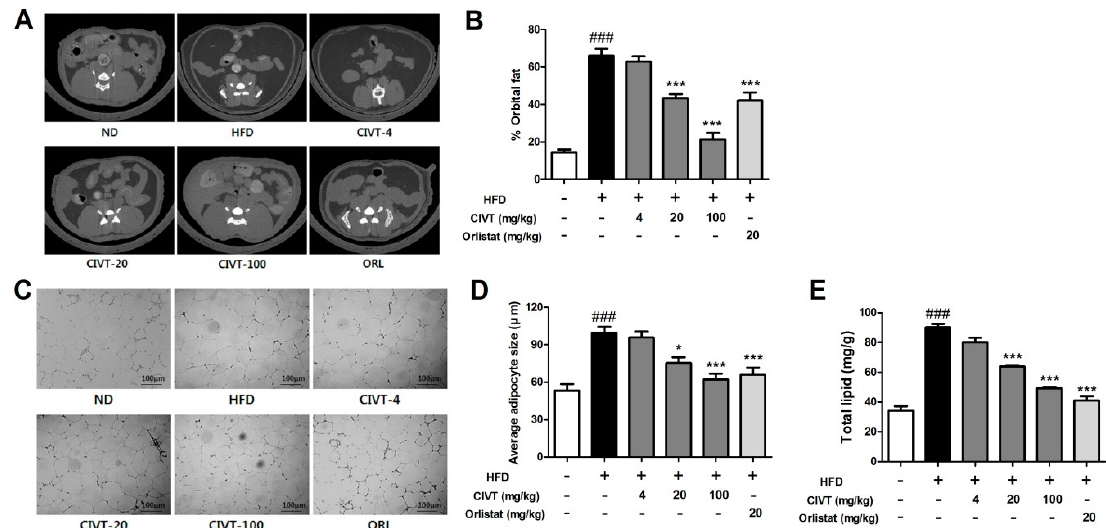
Figure 3. Effects of CIVT on fat deposition and histological alterations and adipocytes size of eWAT and total lipid levels in the liver tissues in HFD-fed obese mice. Micro-CT images were obtained using Skyscan1076 micro-CT scanner. Representative micro-CT images in each group ( n = 6) were selected ( A ). Percentage (%) of orbital fat was analysed using Skyscan program ( B ). Epididymal WAT (eWAT) was removed from the mice after they were sacrificed. The histological alterations of the tissue were observed using H&E staining ( C ). Scale bar: 100 µ m, Original magnification: 100 × . Size of adipocytes from eWAT was measured using Photoshop program ( D ). Total lipids were analysed ( E ). Values represent the means ± SEMs ( n = 6). Data were analysed by Bonferroni correction for post-hoc test. ### p < 0.001 versus the ND group; * p < 0.05 and *** p < 0.001 versus the HFD group.